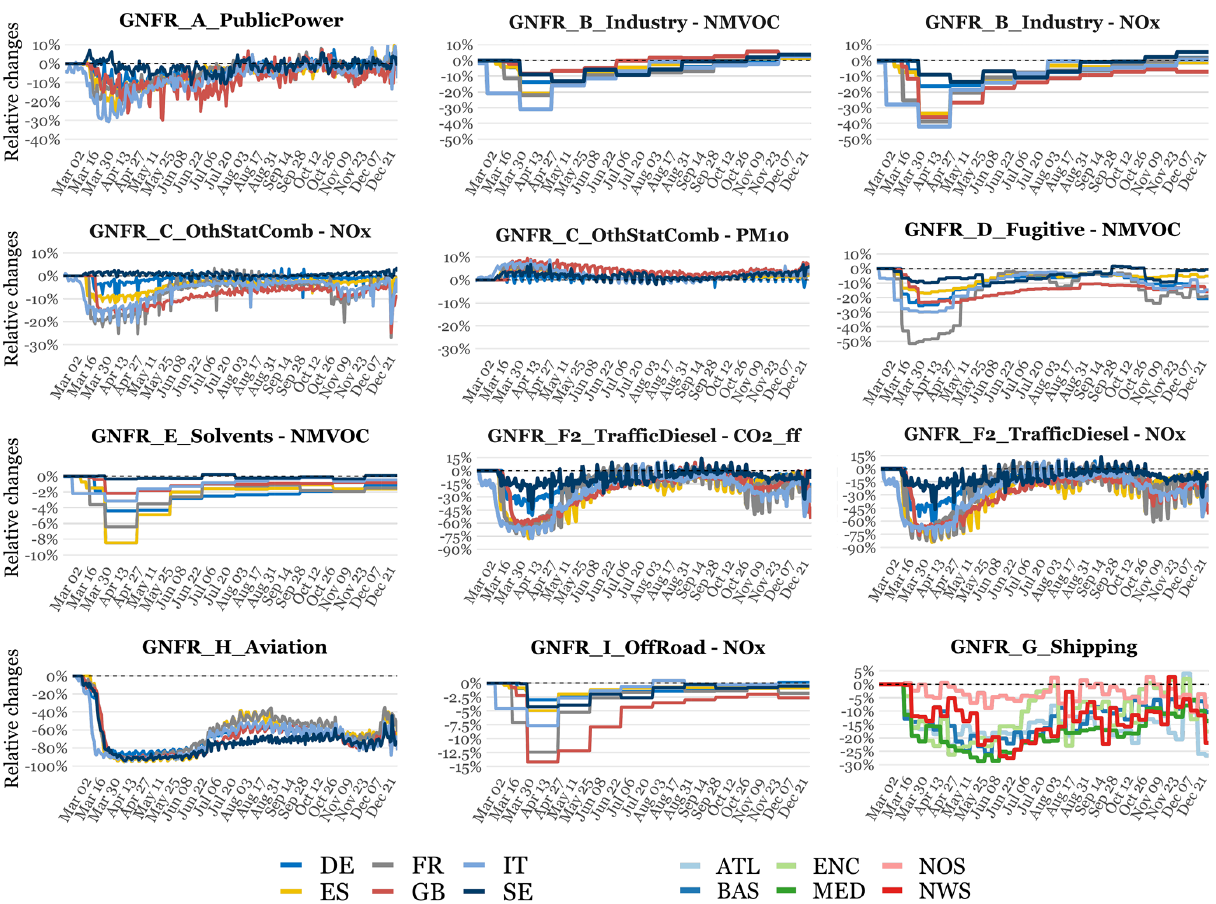
Figure 2. Daily COVID-19 emission adjustment factors computed per GNFR sector and pollutant for selected countries: Germany (DE), Spain (ES), France (FR), the United Kingdom (GB), Italy (IT) and Sweden (SE). For the shipping sectors, adjustment factors are reported for selected sea regions: the Atlantic Ocean (ATL), Baltic Sea (BAS), English Channel (ENC), Mediterranean Sea (MED), North Sea (NOS) and Norwegian Sea (NWS). For the GNFR sectors A (public power), H (aviation) and G (shipping), the constructed adjustment factors are the same for all species. Adjustment factors are reported for the period 21 February to 31 December